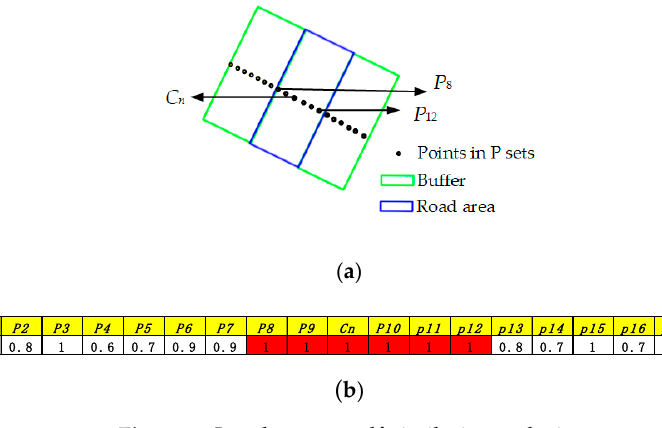
Figure 9. Probability statistics of road width.